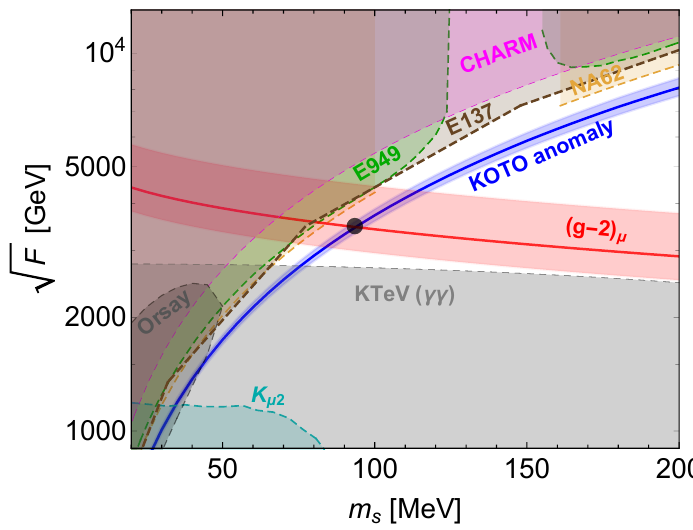
Figure 4 . KOTO excess signals, muon( g (cid:0) 2) anomaly and beam-dump experimental constraints, p plotted as functions of the scalar mass m s and SUSY breaking scale F . Here we set M 1 = 100 GeV, p M 2 = 1 TeV, A 0 = F = 0 : 2, m ~ (cid:22) = m ~ (cid:22) = m ~ (cid:23) = 800GeV, (cid:22) = 15 TeV. Blue: region in which L R can explain the KOTO anomaly. The blue line is the measured central value of the KOTO data. The blue band is the parameter space consistent with the KOTO anomalous events in 1 (cid:27) . Red: region of parameter space that can address the ( g (cid:0) 2) (cid:22) problem in 2 (cid:27) . The solid line corresponds to the central value, while the shaded regions include the 2 (cid:27) compatible values. Green: excluded regions at 95% C.L. by E949 experiment, which constraints on Br( K + ! (cid:25) + X ) with X a long- lived particle. Light-Orange: limits from NA62 on Br( K + ! (cid:25) + (cid:23) (cid:22) (cid:23) ) at 95% C.L. . Magenta: limits on displaced decays of the scalar from the CHARM experiment, which measures displaced decay of neutral particles into e + e (cid:0) ; (cid:13)(cid:13); (cid:22) + (cid:22) (cid:0) . Black: the shaded region is excluded by the Orsay experiment which puts limits on the decaying of a scalar into electron pairs. Gray: limits from KTeV( (cid:13)(cid:13) ) on the process K L ! (cid:25) 0 (cid:13)(cid:13) . Cyan: region excluded by K (cid:22) 2 from searching of light scalars in process K + ! (cid:25) + s . Brown: excluded regions from SLAC beam dump experiment E137 at 95% C.L. The big black point in the parameters space corresponds to the benchmark that can explain both anomalies